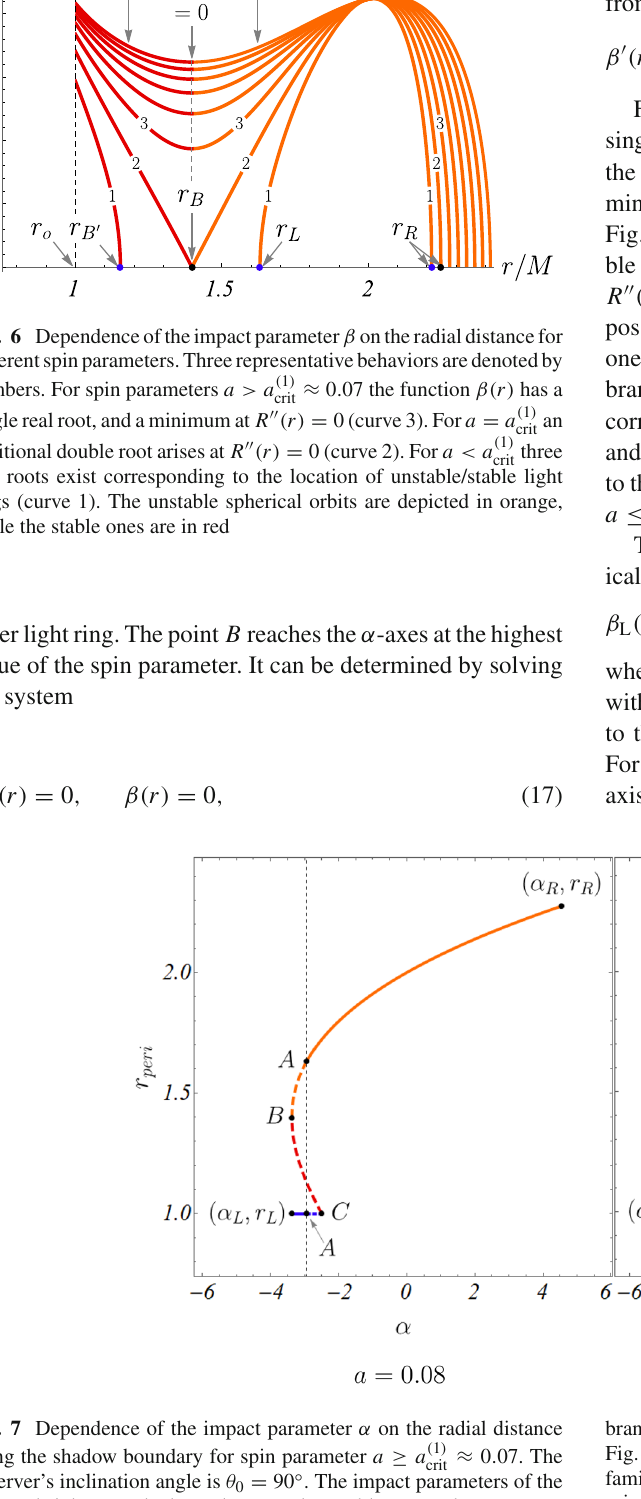
branches is denoted by A . The same color conventions are used as in ( 1 ) ≈ 0 . 07. The Fig. 5. The points B and C are the stability turning points of the two crit families of spherical orbits. Only the unstable spherical orbits located prior to the intersection point A , given by solid lines, contribute to the shadow boundary (see main